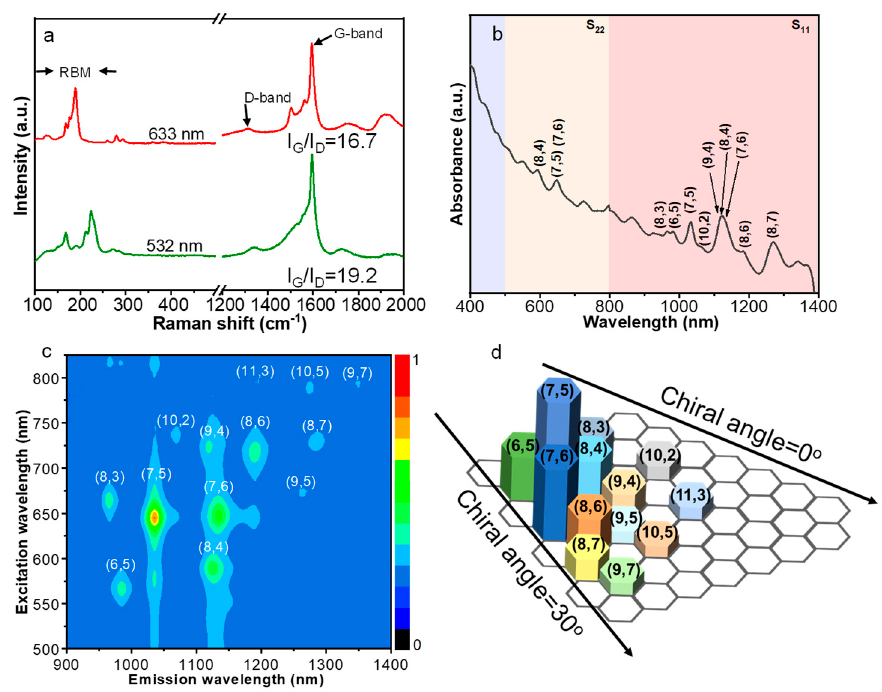
Figure 5. ( a ) Raman spectra of carbon nanotubes grown from Pd@MgO catalyst at 900 °C. ( b ) UV- vis-NIR absorption spectrum and ( c ) PL spectrum of SWNTs. ( d ) Chirality distribution of SWNTs deduced from PL emission intensities.